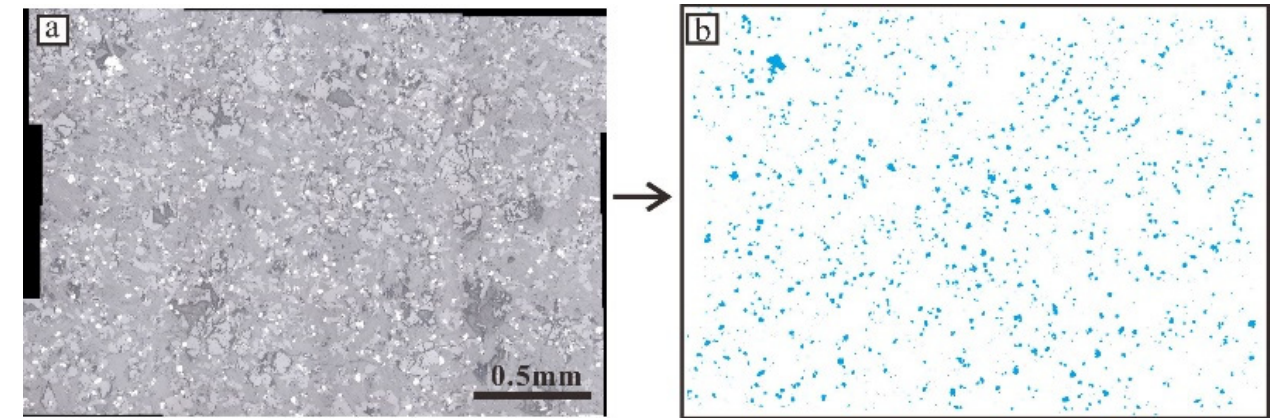
Figure 4. An example (17JSB01) of titanomagnetite particle outlines is extracted from a stitched photomicrograph taken via a reflection microscope. ( a ): The reflection microscope photograph of 17JSB01. The white mineral particles are titanomagnetite; ( b ): Image of titanomagnetite particles outlined manually used for CSD analysis.